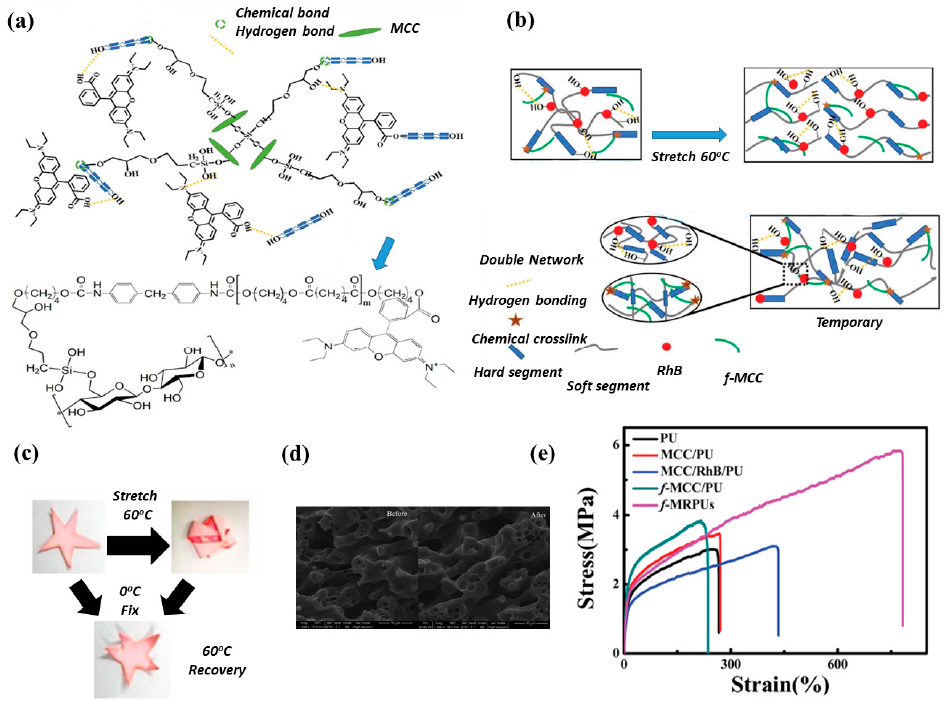
Figure 6. Proposed reactive mechanism and structure of double-networked TPU composites ( a ), shape change pa tt ern of thermo-sensitive TPU composite ( b ), shape change of TPU composite ( c ), SEM micrographs of TPU composite before and after thermo-mechanical testing ( d ), mechanical properties of neat TPU and TPU composites ( e ). Adapted from